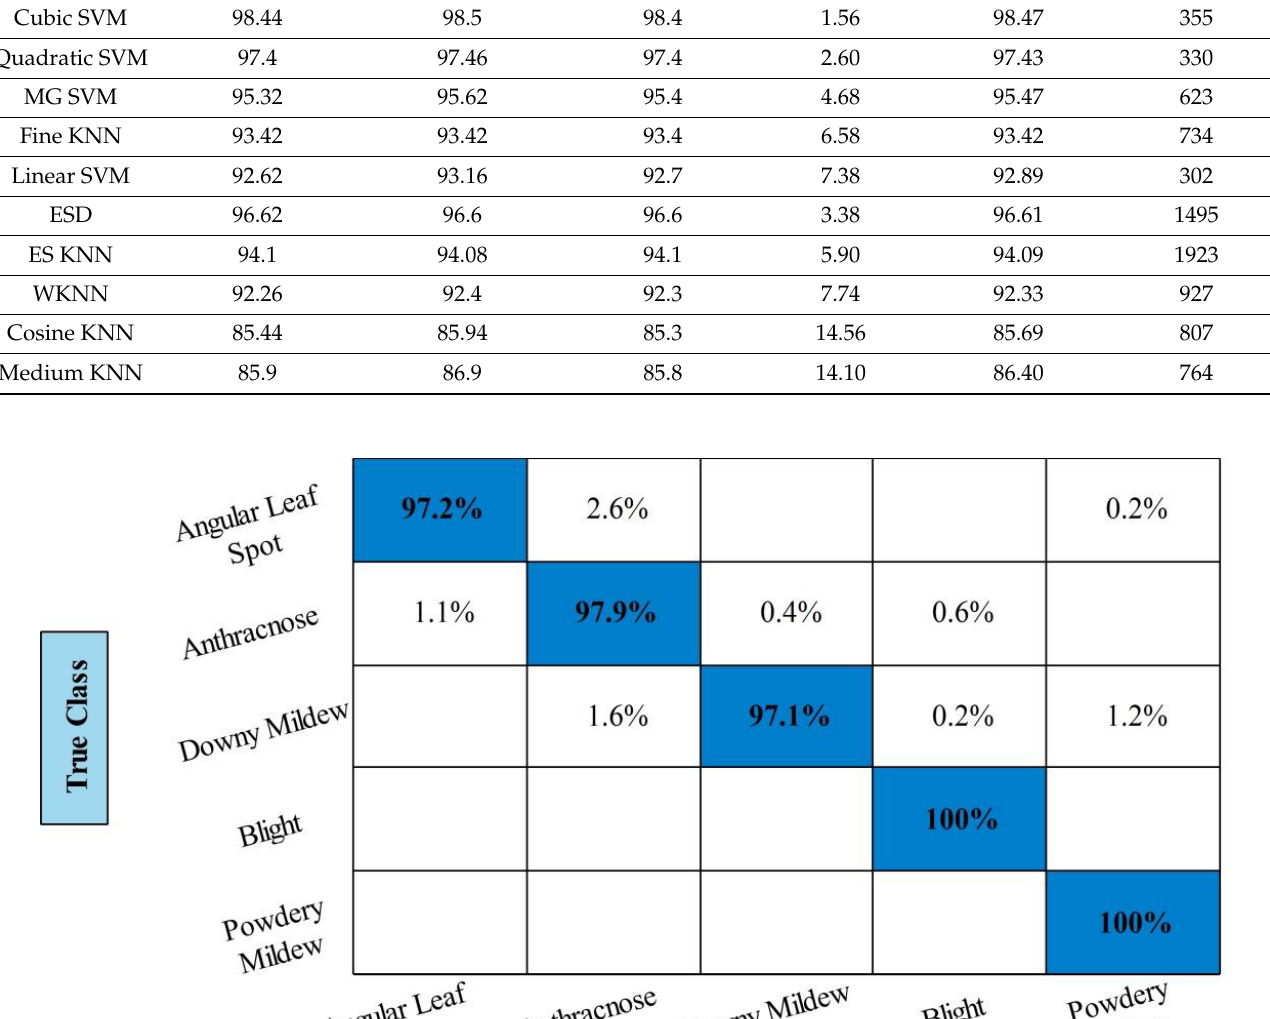
Table 7. Classification results using proposed Entropy - ELM selection approach.